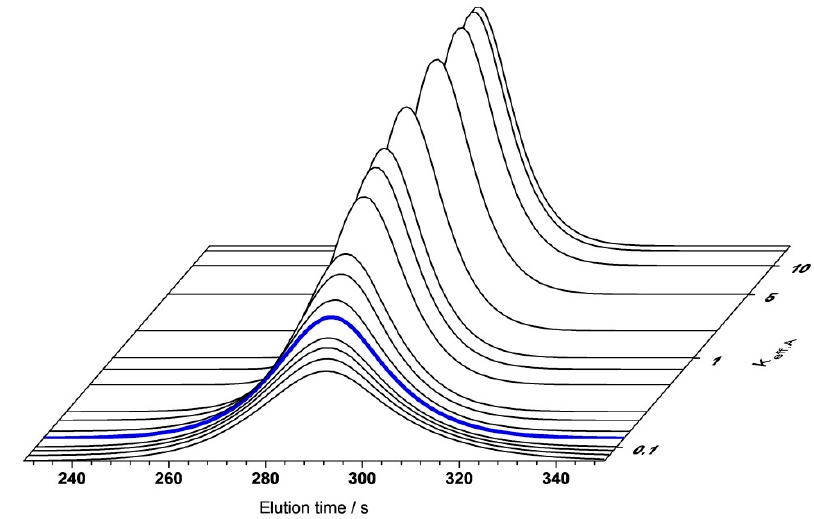
Figure 11. Sensitivity analysis of rate coefficient k eff,A . 7.5 CVs gradient elution; flow rate 3 mL/min. The blue line represents a rate coefficient of 0.129 (1/s).